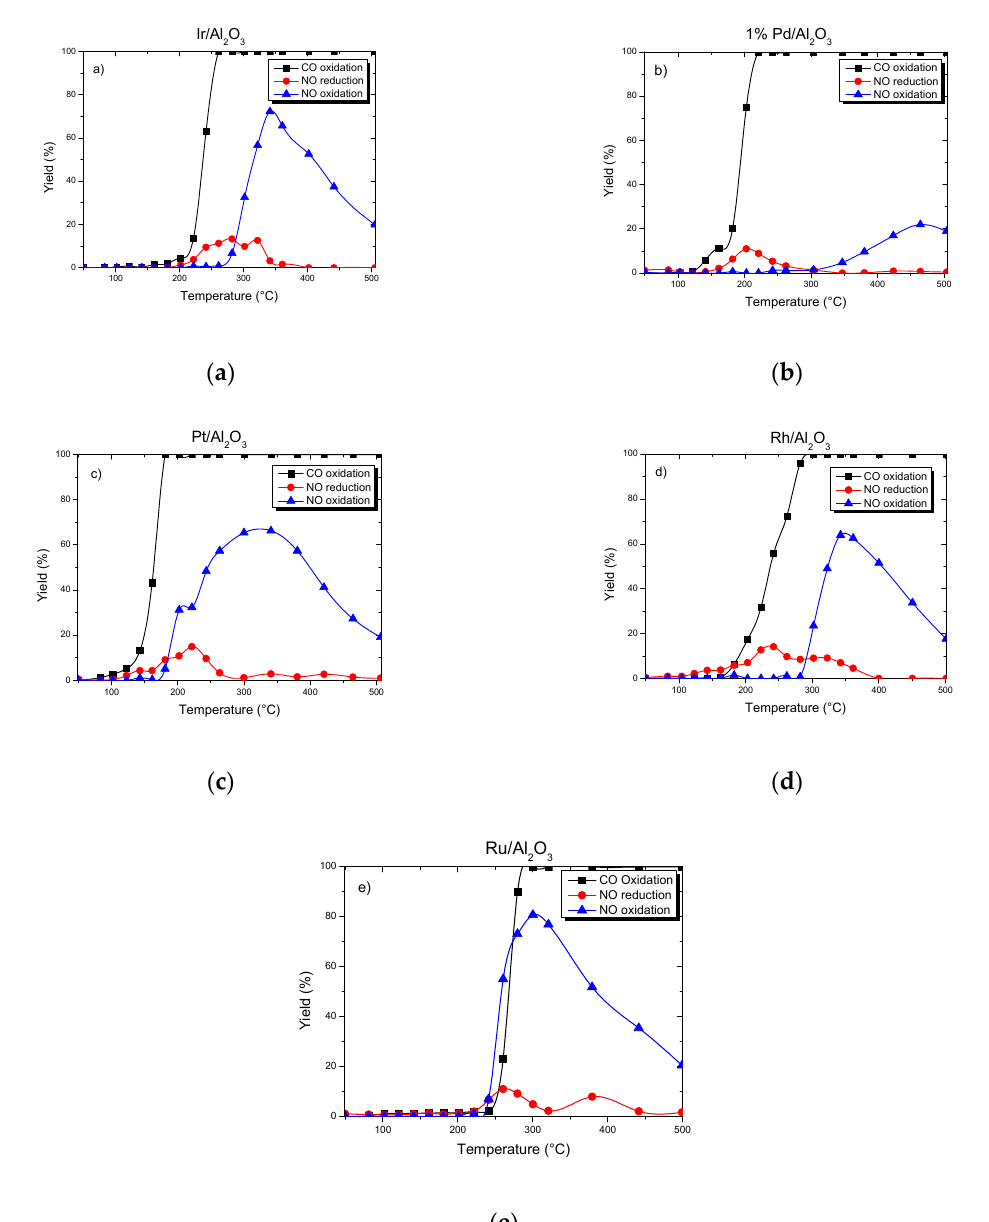
Figure 6. Catalytic activity for the ( a ) Ir, ( b ) Pd, ( c ) Pt, ( d ) Rh, ( e ) Ru, catalysts supported on alumina. Feedstream composition: 0.02% NO, 0.5% CO, 10% O 2 and 20% CO 2 , and balance He. Space velocity: 2.24 · 10 4 h − 1.